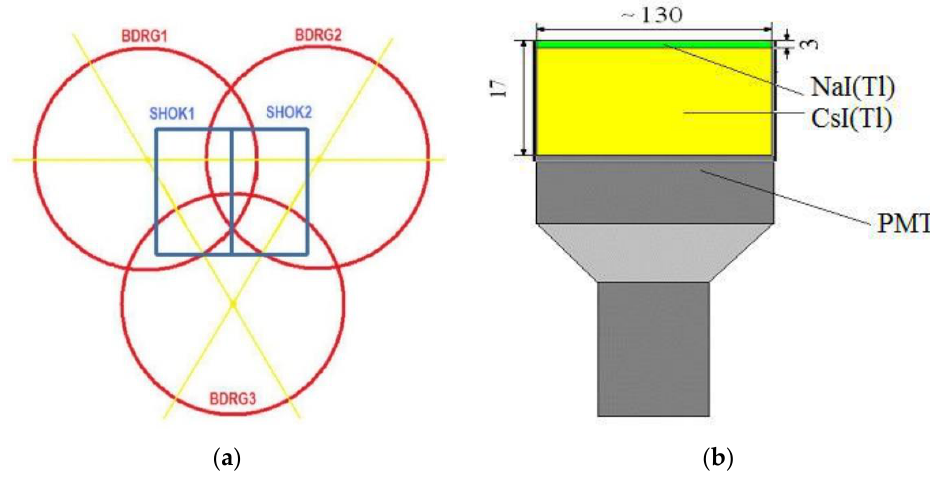
Figure 1. ( a ) FOV of BDRG gamma detectors, together with the FOV of SHOK optical cameras. ( b ) The design of the scintillation detector of the BDRG